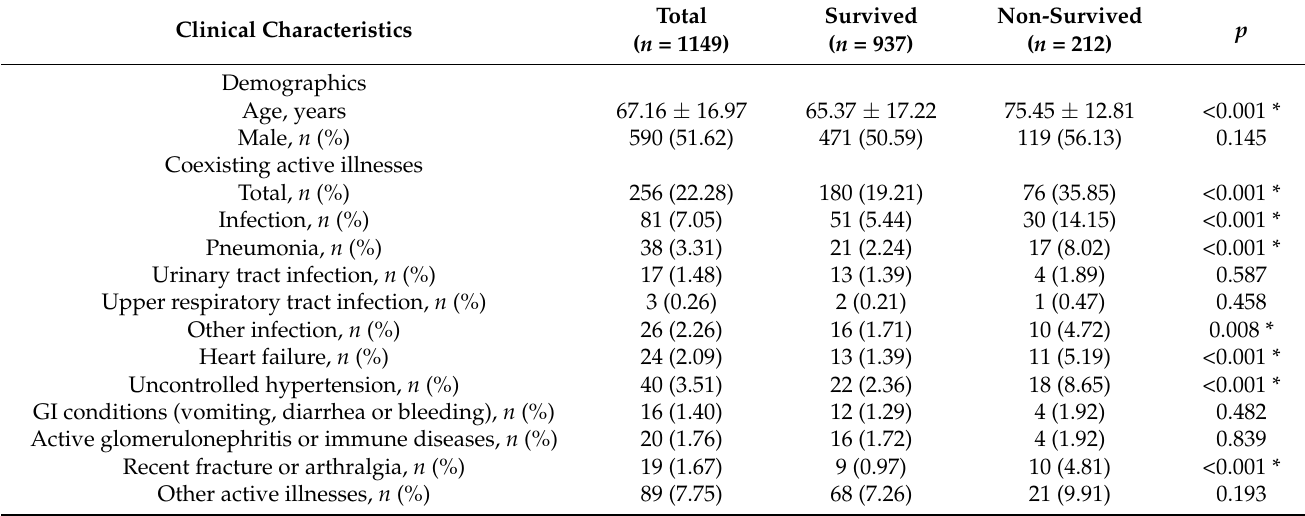
Figure 1. The flow diagram of the study. A total of 1394 AKI cases were found after the administration of the COVID-19 vaccine. After combining with patient data and excluding missing data and erred inputs, 1149 AKI cases were finally selected in this study. Of these, 627 (54.6%) cases were reported following the Pfizer-BNT COVID-19 vaccine, and 433 (37.7%) were reported after the Moderna vaccine. Table 1. Clinical characteristics in survived AKI patients after COVID-19 vaccination compared to deceased patients, sourced from the VAERS database (December 2020 to June